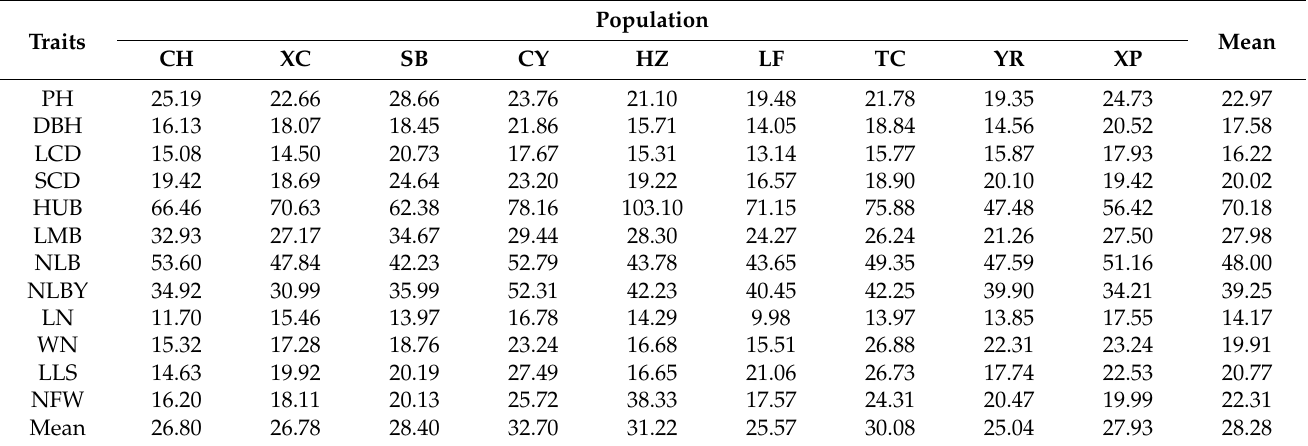
Table 3. Characteristic of phenotypic traits in populations of P. yunnanensis revealed by variance com-